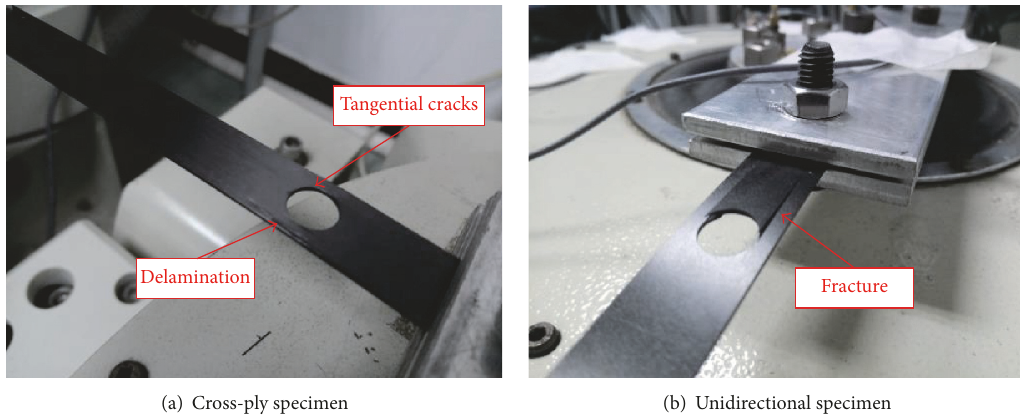
Figure 14: The difference of vibration fatigue between specimens with different